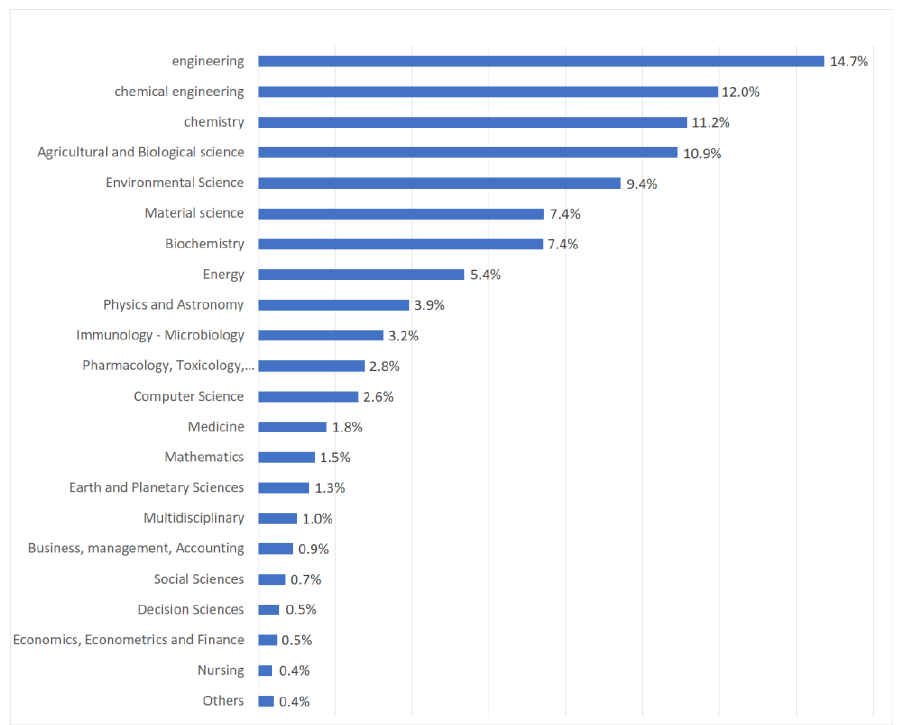
Figure 2. Research fields applying RSM.